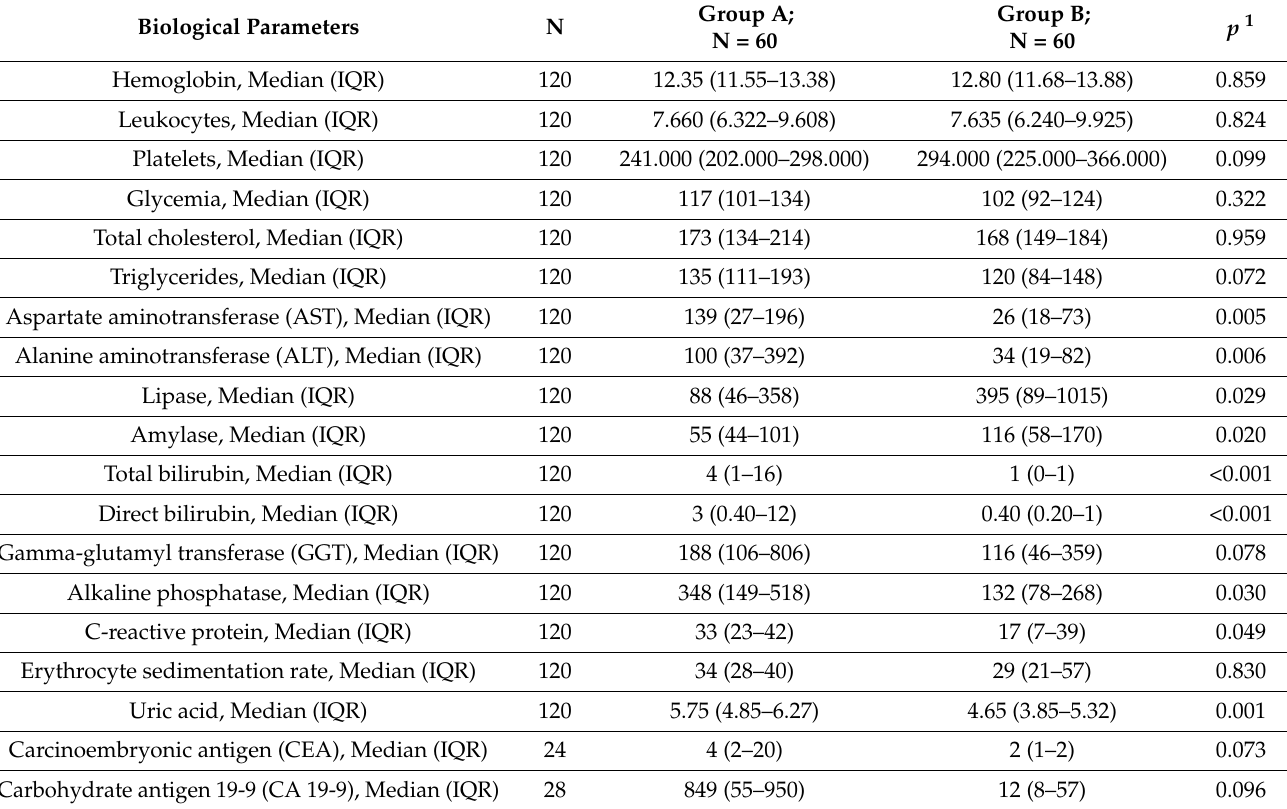
Table 2. Biological parameters in patients with pancreatic cancer vs. chronic pancreatitis.